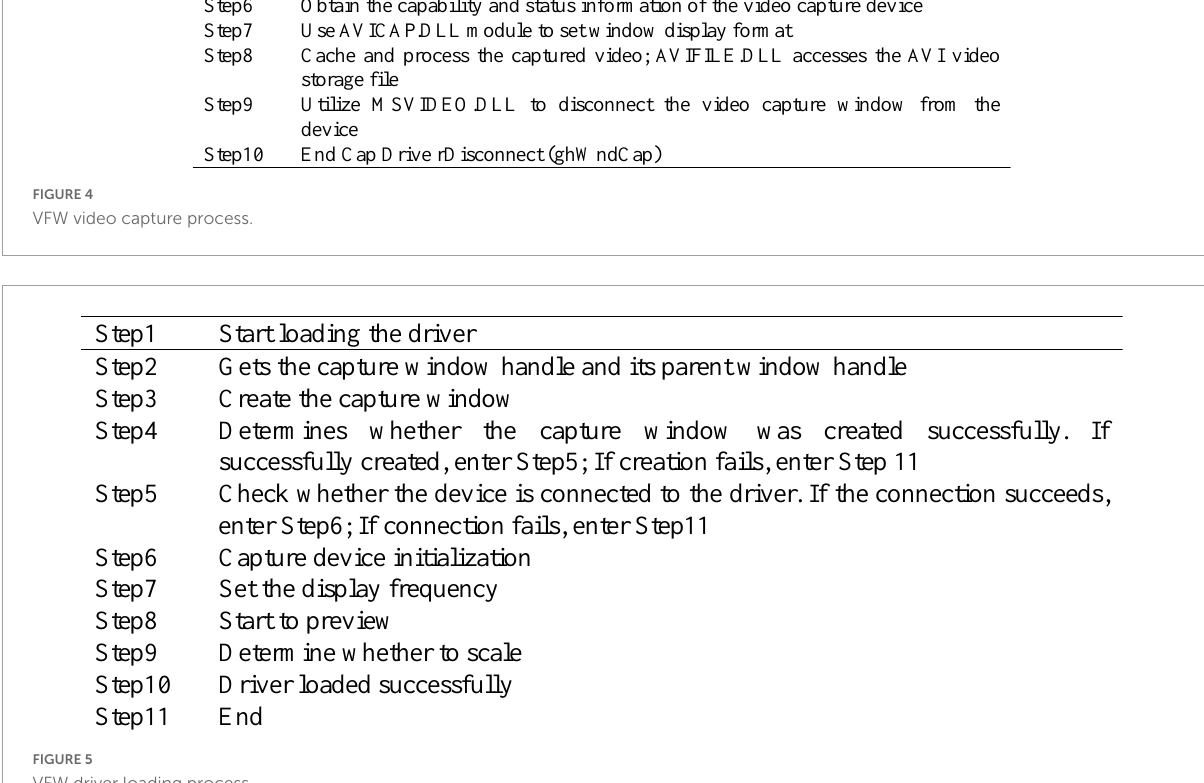
FIGURE5 VFW driver loading